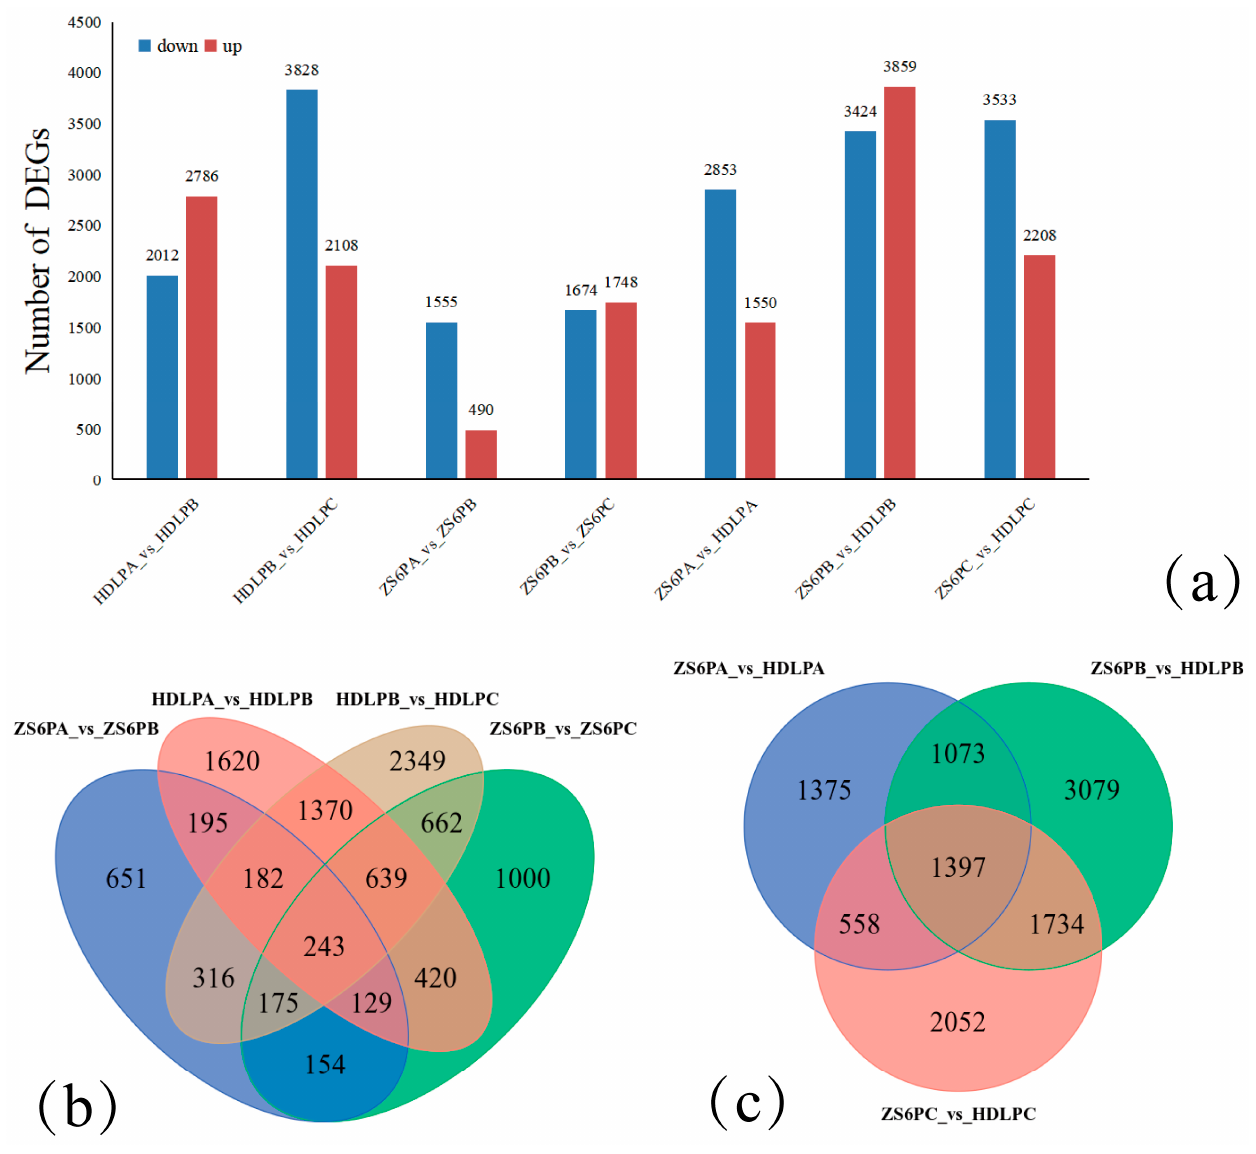
Figure 4. DEG distribution in pair ‐ wise comparisons. ( a ) Numbers of DEGs in pair ‐ wise comparisons. ( b , c )Venn diagram of the number of DEGs revealed by pair ‐ wise comparisons.